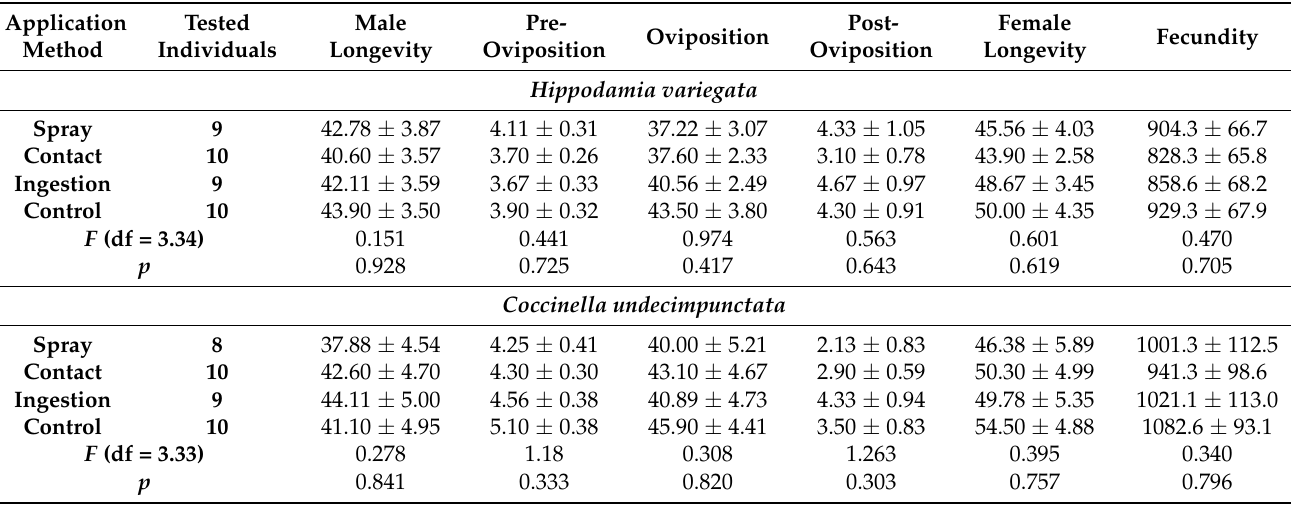
Table 2. Effect of Beauveria bassiana on male longevity, preoviposition, oviposition, postoviposition, total female longevity (days ± standard error) and fecundity (eggs/female) of Hippodamia variegata and Coccinella undecimpunctata treated at their 1st larval instar with three different application methods of the